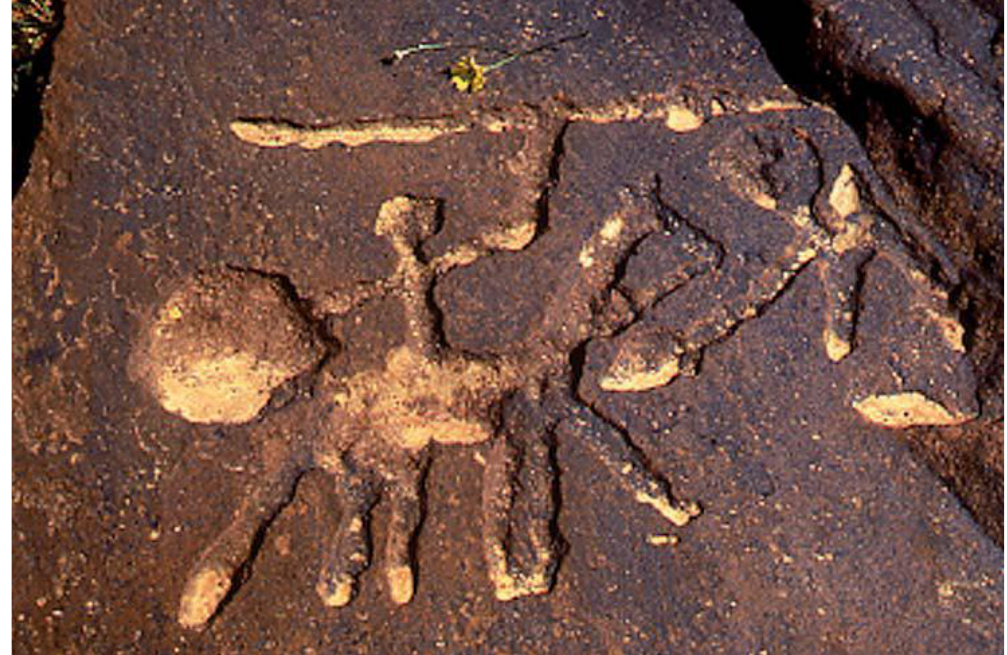
Figure 4. Fighting scene from Foum Ech Chenna, north of Zagora, River Draa